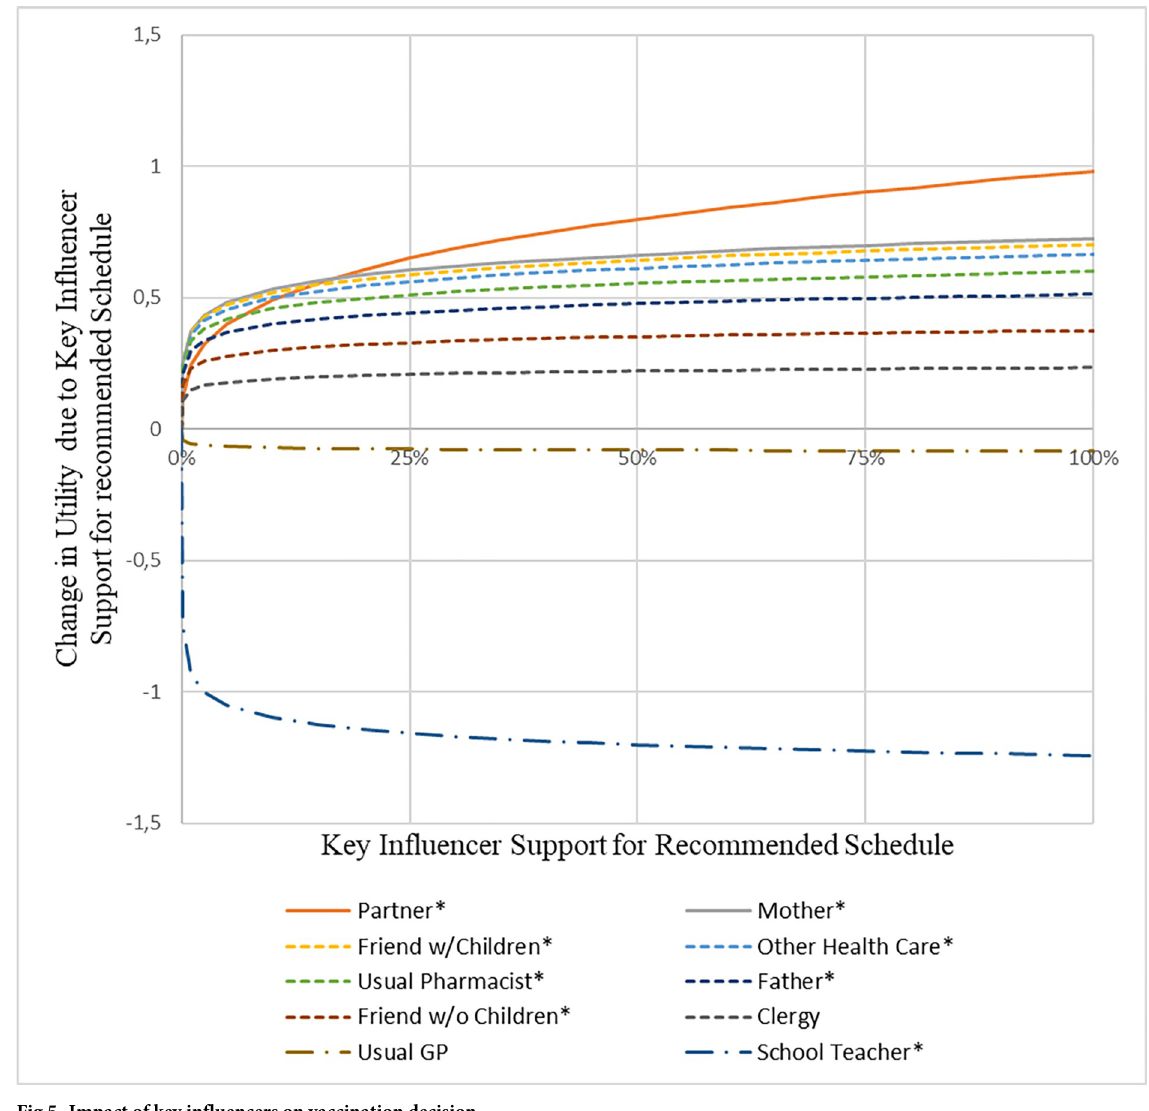
Fig 5. Impact of key influencers on vaccination